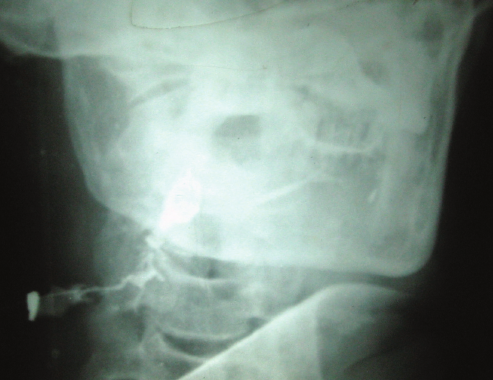
Figure 2: Fistulogram showing the communication of the fistula opening with the submandibular duct (Wharton’s